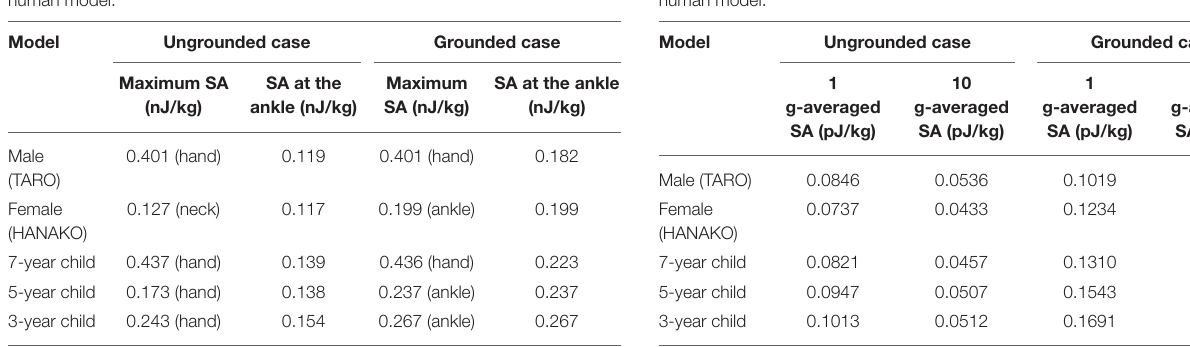
TABLE 6 | Peak 1 g-averaged and 10 g-averaged SA normalized by an ICNIRP-prescribed power density limit of 2 W/m 2 for general exposures to various human